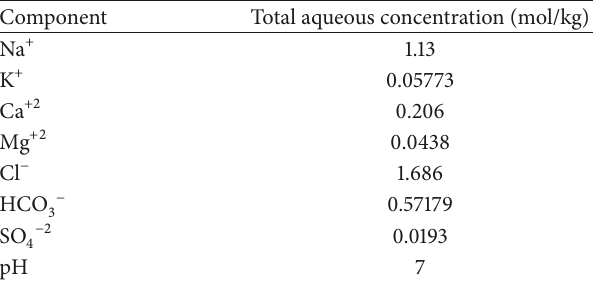
Table 2: Initial fluid